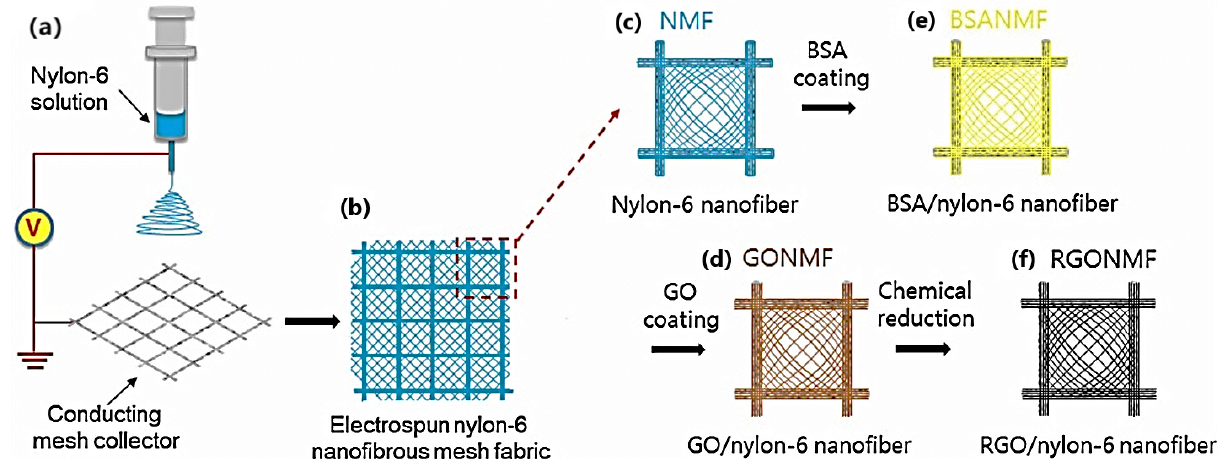
Figure 33. Schematic of the preparation of RGO/nylon-6 nanofiber. ( a ) electrospinning of nylon-6 solution ( b ) electrospun nylon-6 fabric ( c ) nylon-6 nanofiber ( d ) BSA-nylon-6 nanofiber ( e ) GO coating